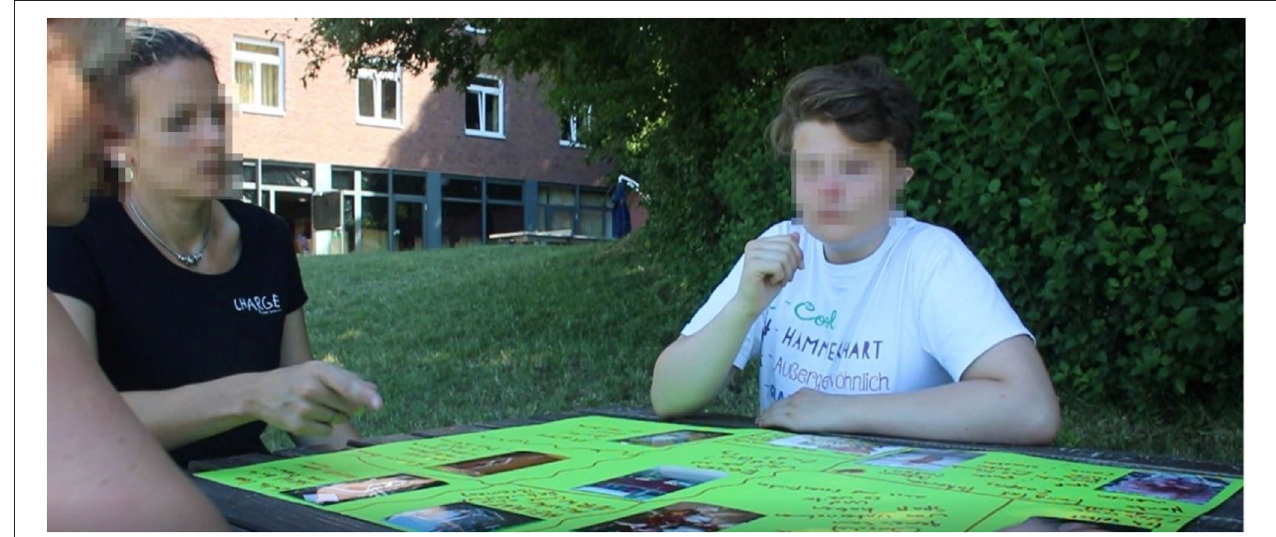
FIGURE 2 | Screenshot Interview with sign language interpreter and